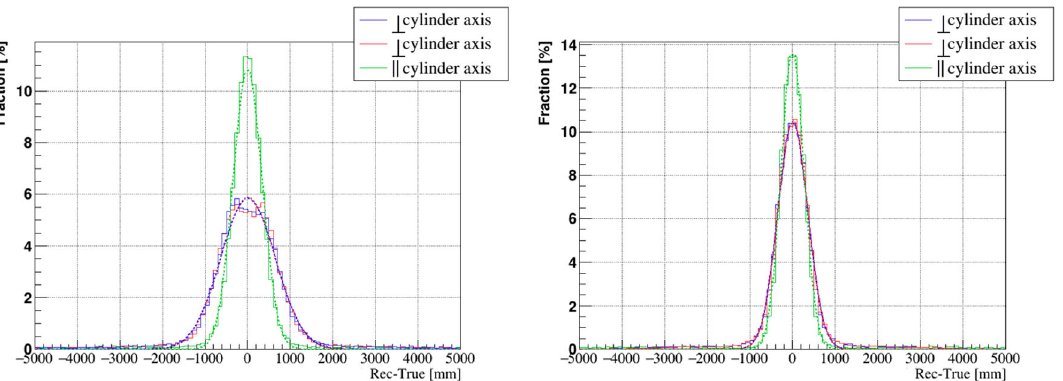
Fig. 3 Reconstruction performance with respect to positron true position, for geo- (left) and reactor ν e (right), integrated throughout the whole detector and energy spectrum